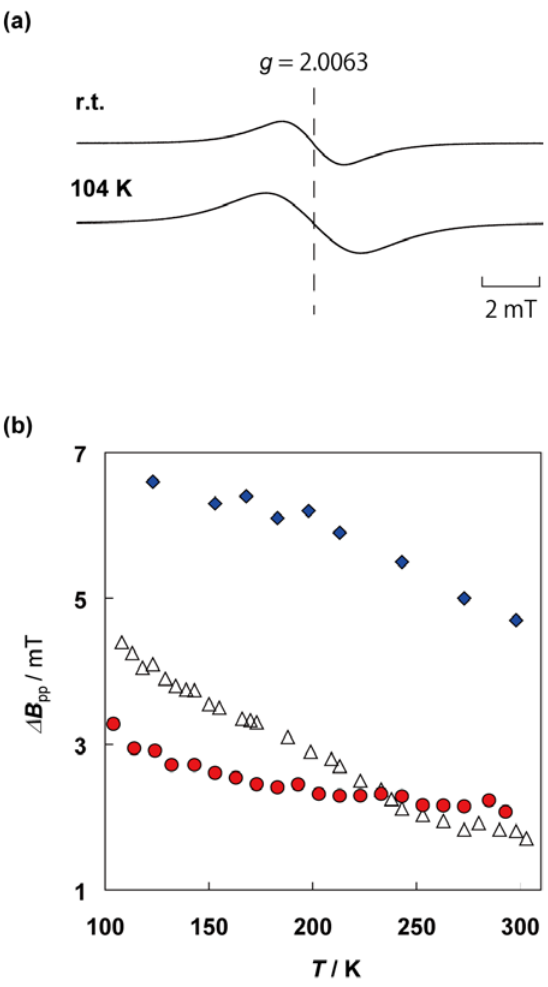
Figure 3. Powder ESR spectra of compound 1 measured at 293 K (top) and 104 K (bottom) (a) , and temperature dependence of the peak-to-peak line width, Δ B circles), TPP/TEMPO IC (open triangles) and [TPP/(TEMPOL) (blue diamonds), respectively (b)